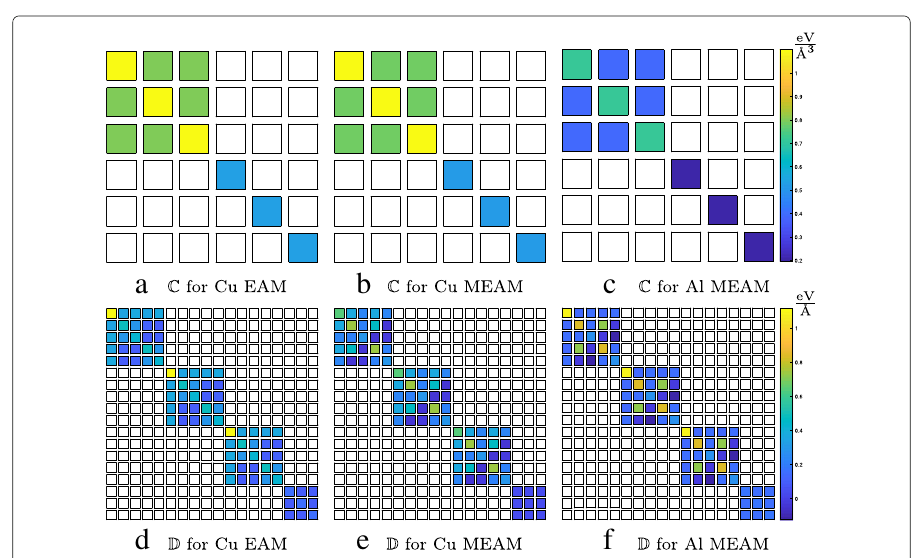
Fig. 3 Voigt representation of the elastic tensors C and gradient-elastic tensor D for fcc Al and Cu, computed from the interatomic potentials Lee (2014) and Mendelev (2014). a and d Cu for EAM potential (Mendelev 2014). b and e Cu for MEAM potential (Lee 2014). c and f Al for MEAM potential (Lee 2014)